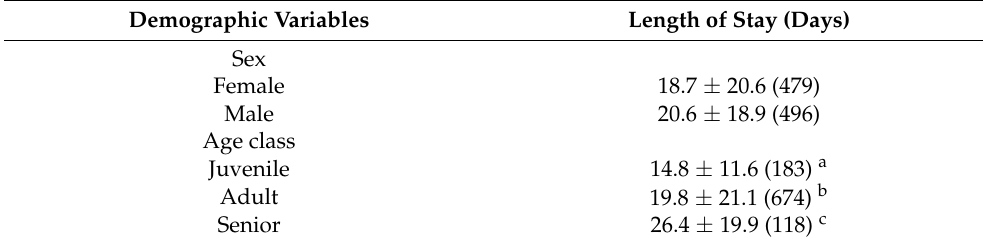
Table 3. Length of stay (mean ± SD , in days) for shelter dogs placed up for adoption in relation to sex and age class, with sample sizes in parentheses. Within specific variables, values with different superscript letters are significantly different.